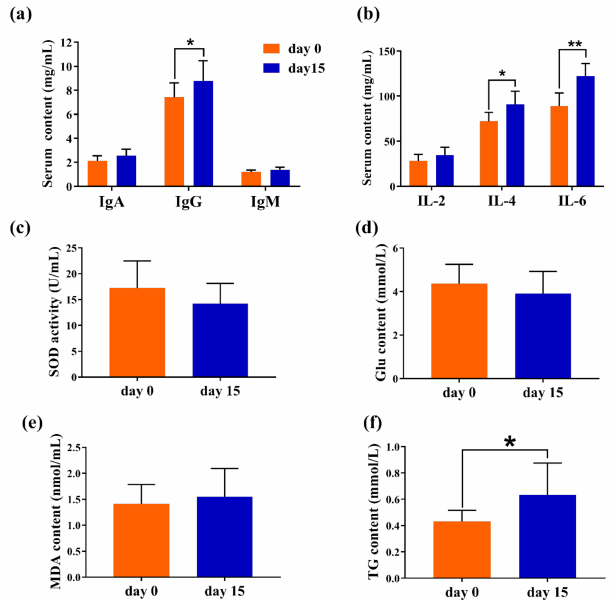
Figure 2. The effect of the administration of Bacillus amyloliquefaciens-9 on serum immune and bio- chemical indices of six treated Saanen kids suffering diarrhea at day 0 and 15. Kids were fed with 0.3% ( w / v ) Bacillus amyloliquefaciens-9 added to raw milk for two weeks. ( a ) IgA, IgG, and IgM concentrations. ( b ) Serum IL-2, IL-4, and IL-6 concentrations. ( c ) Superoxide dismutase concentra- tion. ( d ) Serum concentrations of glucose. ( e ) Serum malondialdehyde concentration. ( f ) Serum triglyceride concentration. Data are means ± SEM. * p < 0.05 and ** p < 0.01 by Student’s t